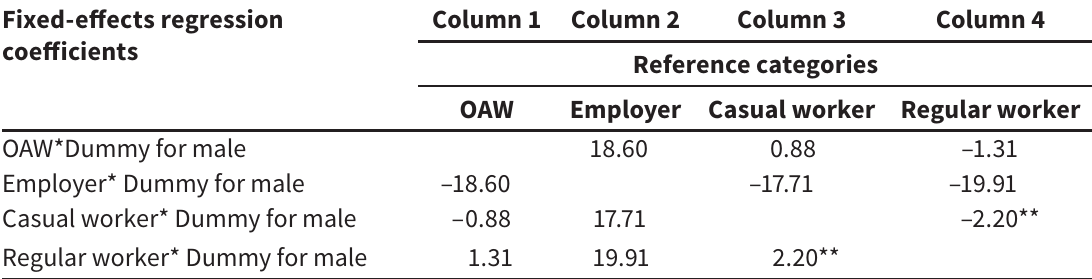
Fixed-effects regression coefficients of the interaction between sectoral choice and gender